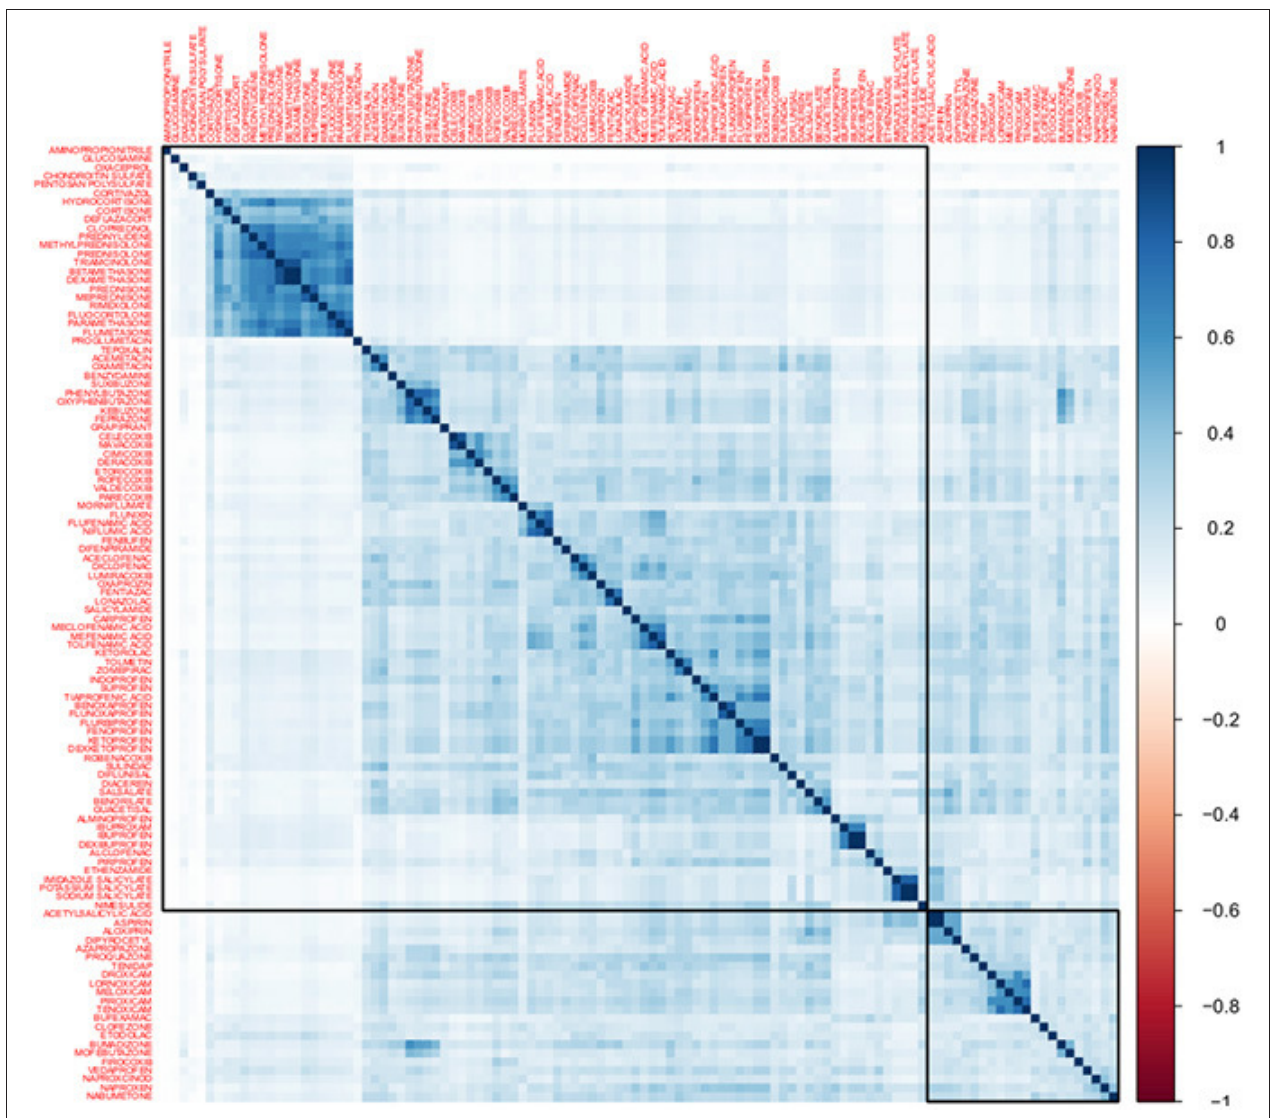
FIGURE 2 | Heatmap of Tanimoto structural similarity. This heatmap represents structural similarities between 110 anti-inflammatory drugs. The color intensity is proportional to the similarity between the chemical structure of two drugs measured using the Tanimoto coefficient. Drugs were ordered using non-supervised hierarchical clustering. Clusters in this matrix contain drugs with close chemical structures. For instance, a large cluster (purple outline) contains hydrocortisone and other drugs derived from